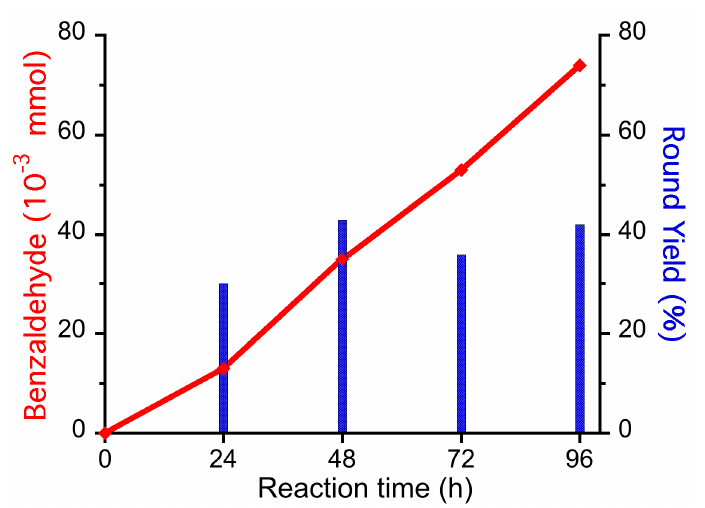
Figure 3. Recycle tests for the selective toluene oxidation to benzaldehyde under O 2 atmosphere in a biphasic system PhCH 3 -H 2 O. Conditions: V = 20 mL; PhCH 3 :H 2 O 1:1 v/v , pH = 1, H 2 O 2 0.05 mmol, NH 4 VO 3 0.01 mmol at 60 °C.